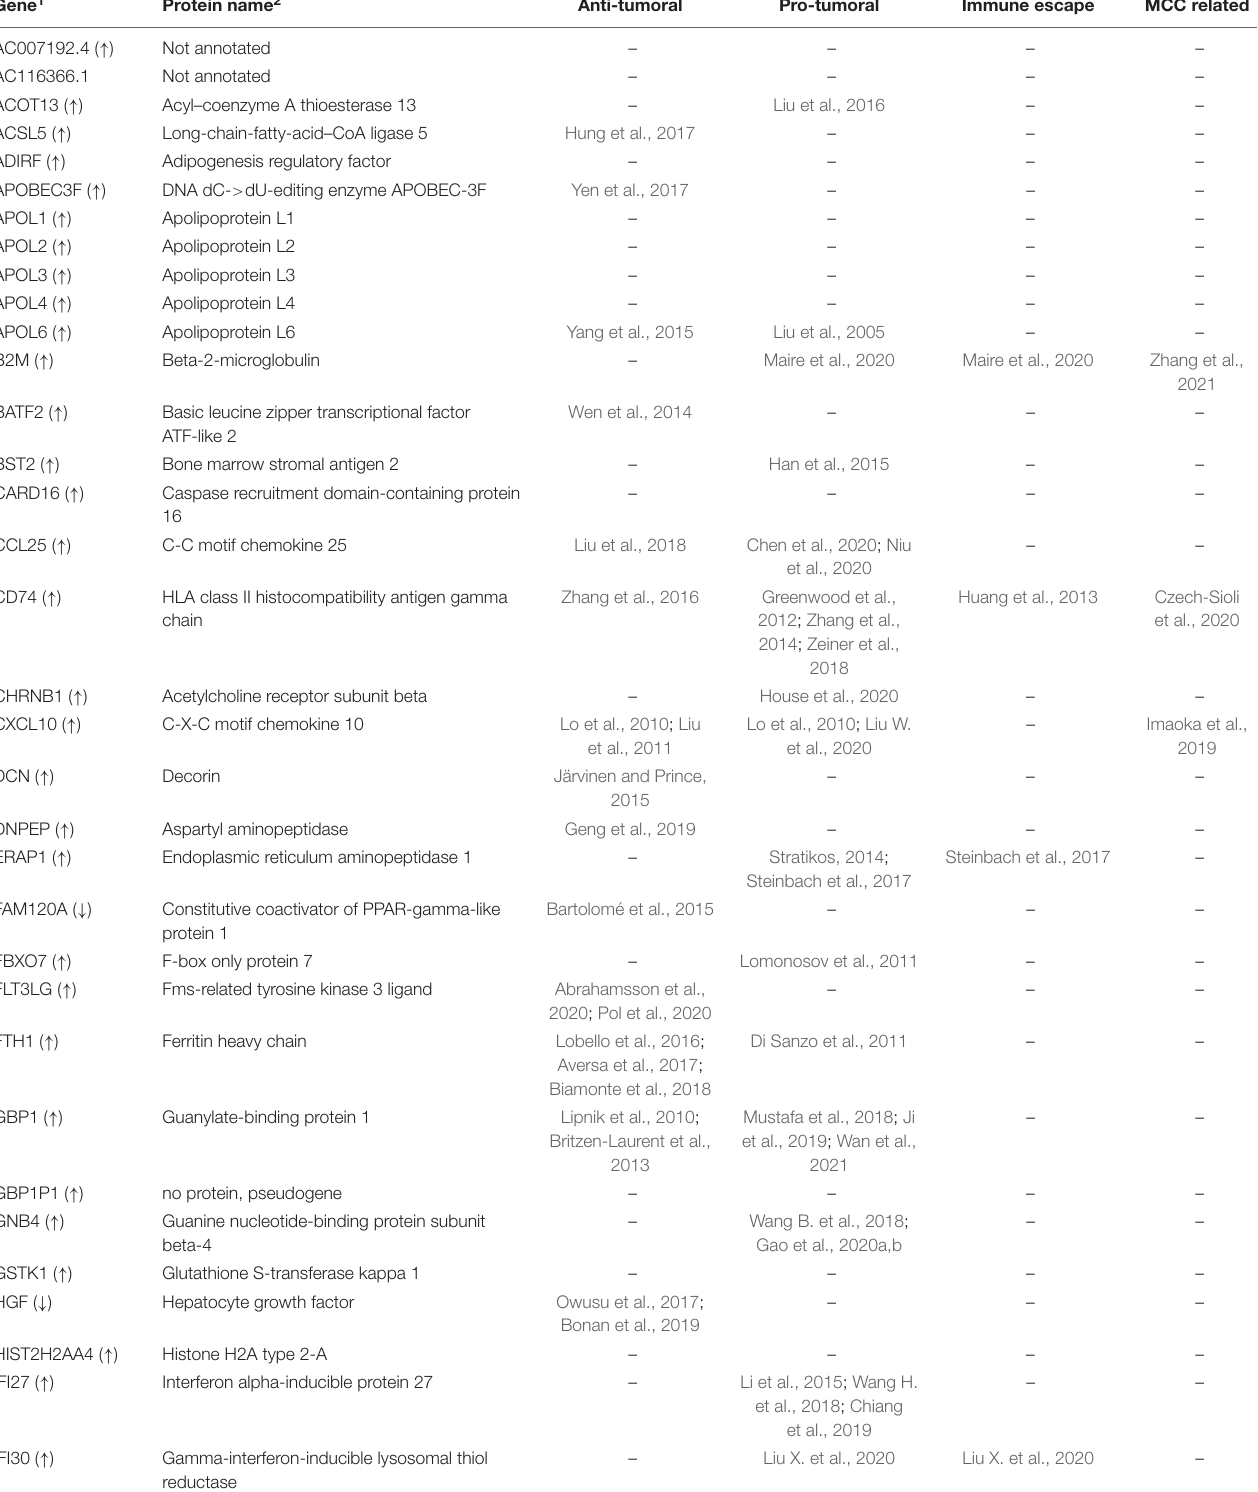
TABLE 1 | Overview of all differentially expressed genes categorized according to their activity in cancer